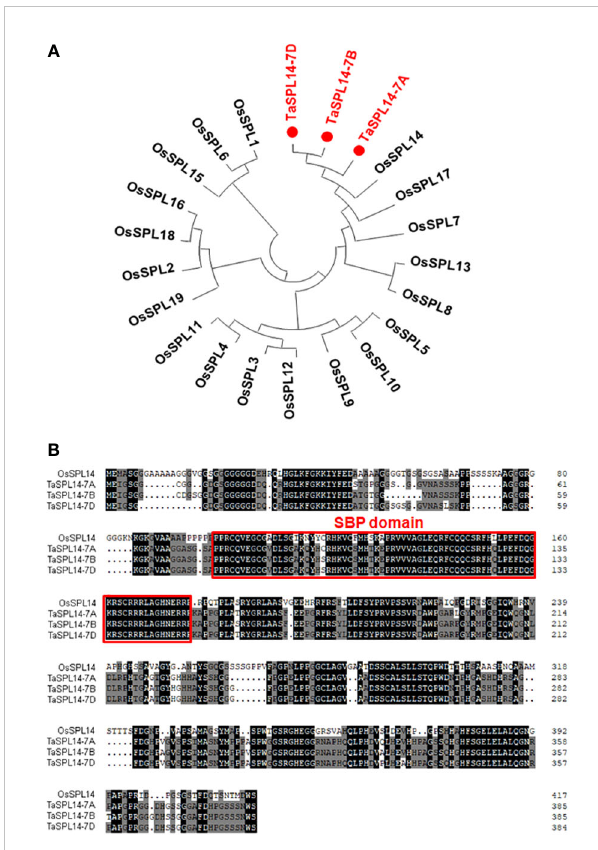
FIGURE 1 Phylogenetic tree and sequence alignment of TaSPL14 homoeologs. (A) Phylogenetic tree constructed from the 19 rice SPL proteins and three TaSPL14 homoeologs using the neighbor-joining method with a bootstrap value of 1000 by MEGA5.0. TaSPL14 homoeologs are marked in red. (B) Sequence alignment of OsSPL14 and TaSPL14 homoeologs. The conserved SBP domain is indicated by the red